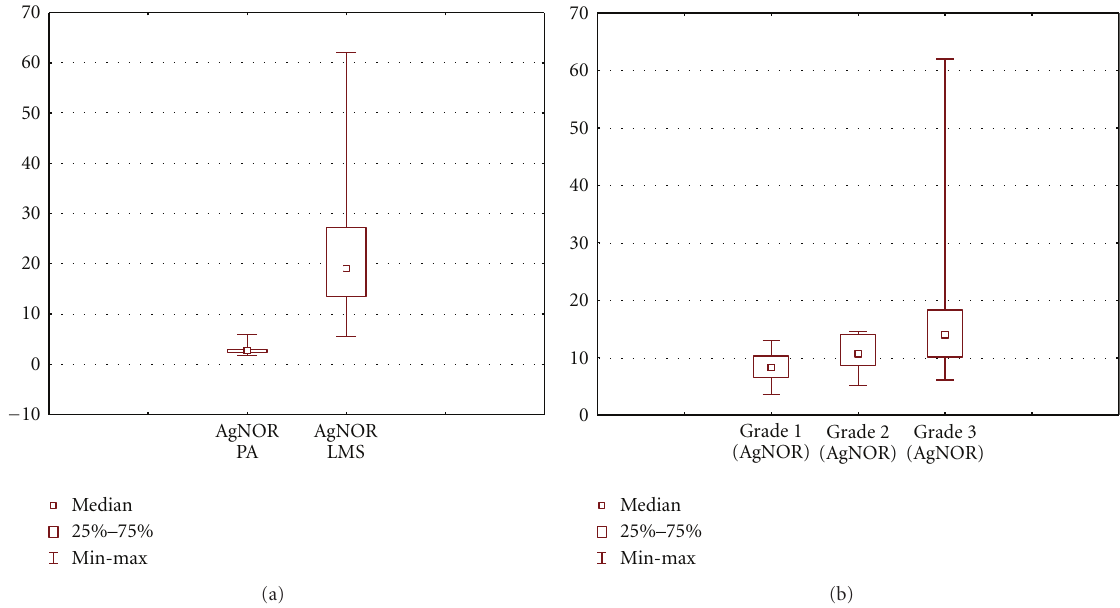
Figure 3: The number of AgNORs of endothelial cells in the PA and LMS: (a) total and (b) at di ff erent grades of malignancy of LMS. Data are presented as median/quartile/range.